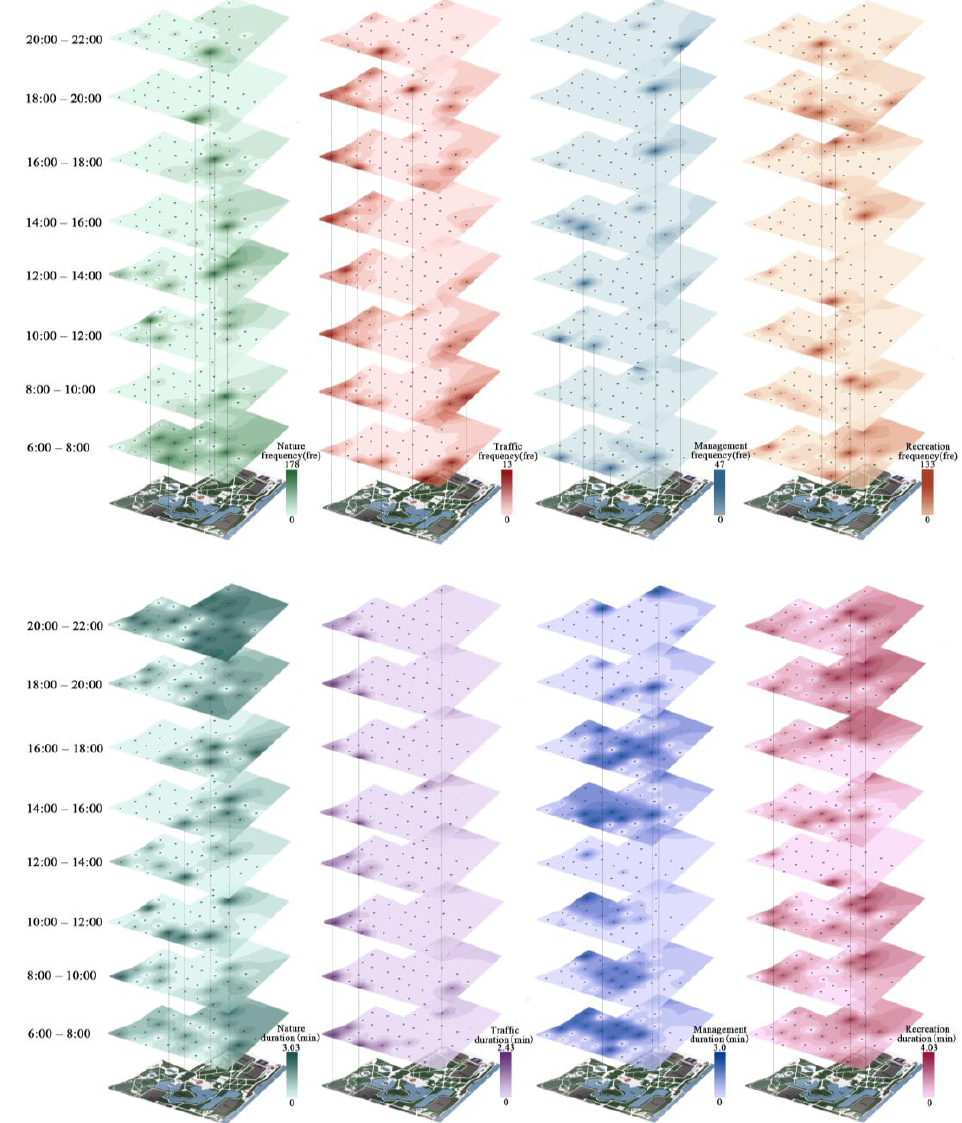
Figure 9. Spatial distribution of natural, traffic, management, and recreational sounds.